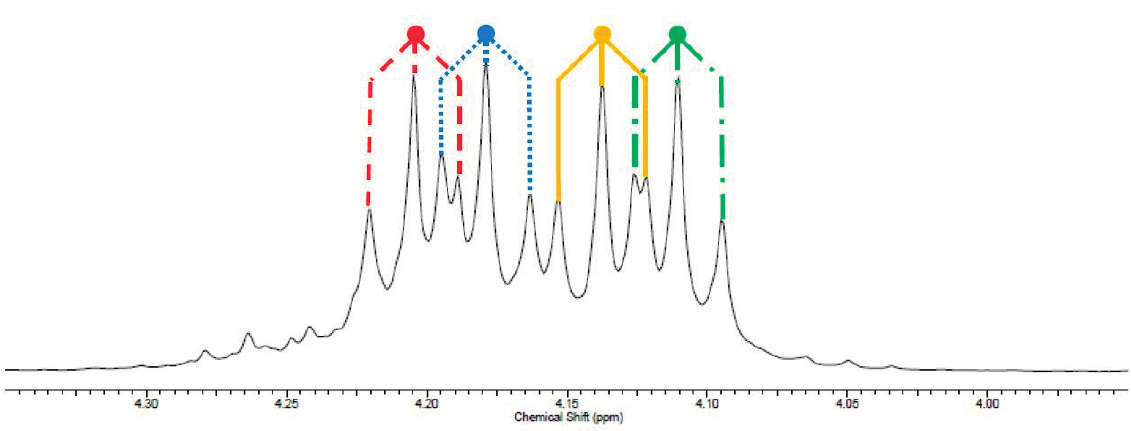
Figure 2. 1 H NMR spectra expansion of multiplicity for the peaks of the H5 and H6 region, showing assignment of four triplets as CH 2 s with UN–UN (red), SAT–SAT (green), UN–SAT (blue–yellow) and SAT–UN (yellow–blue) ester configuration. Assignments are